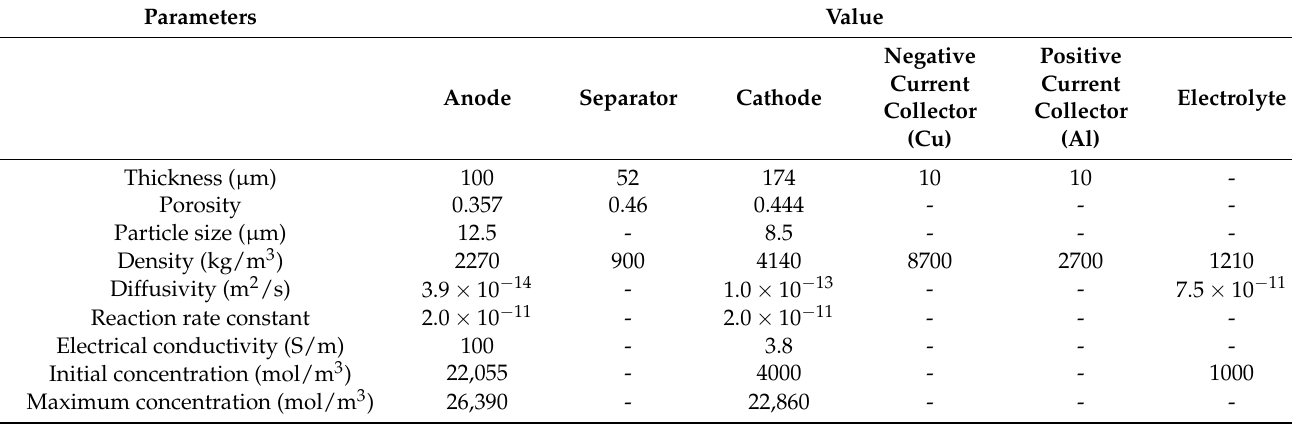
Table 1. Parameters and dimensions of initial LIB cell